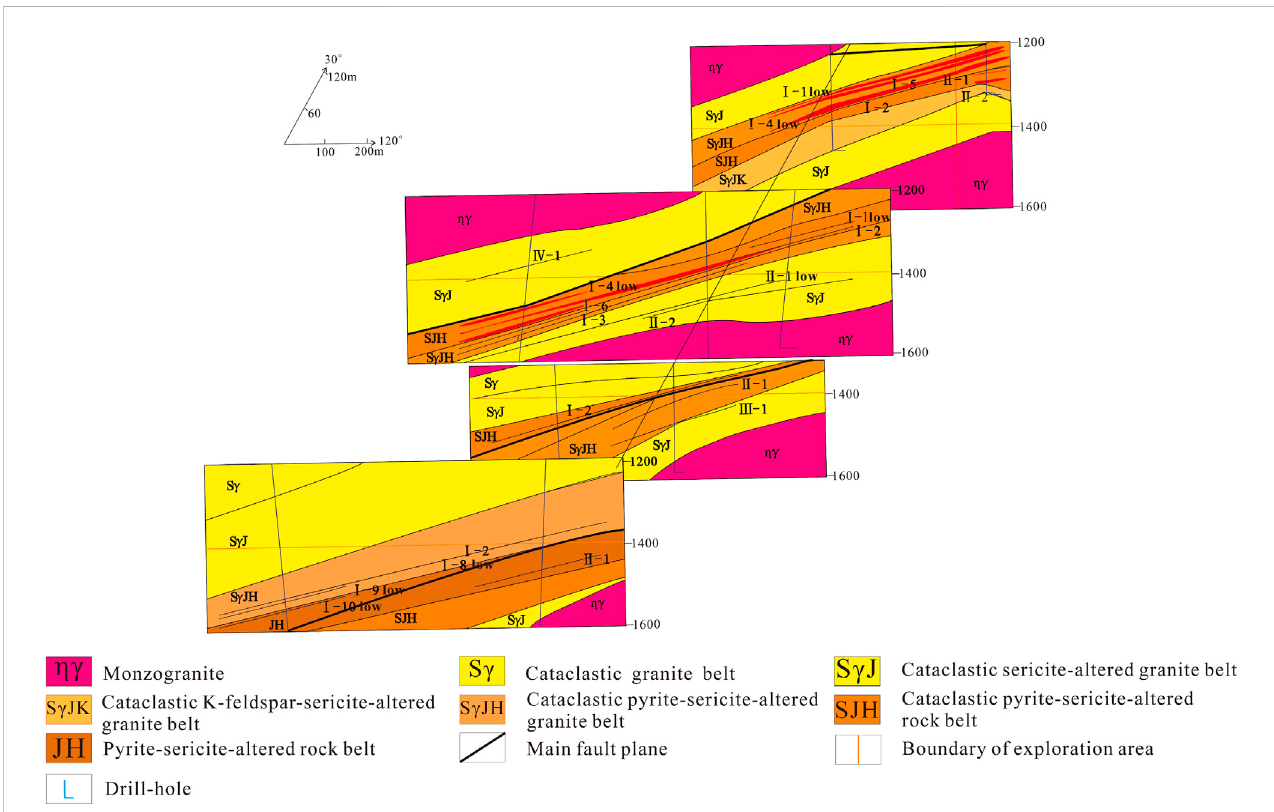
FIGURE 5 Integrated pro fi le north of the Zhaoxian gold deposit (modi fi ed after Wang et al.,